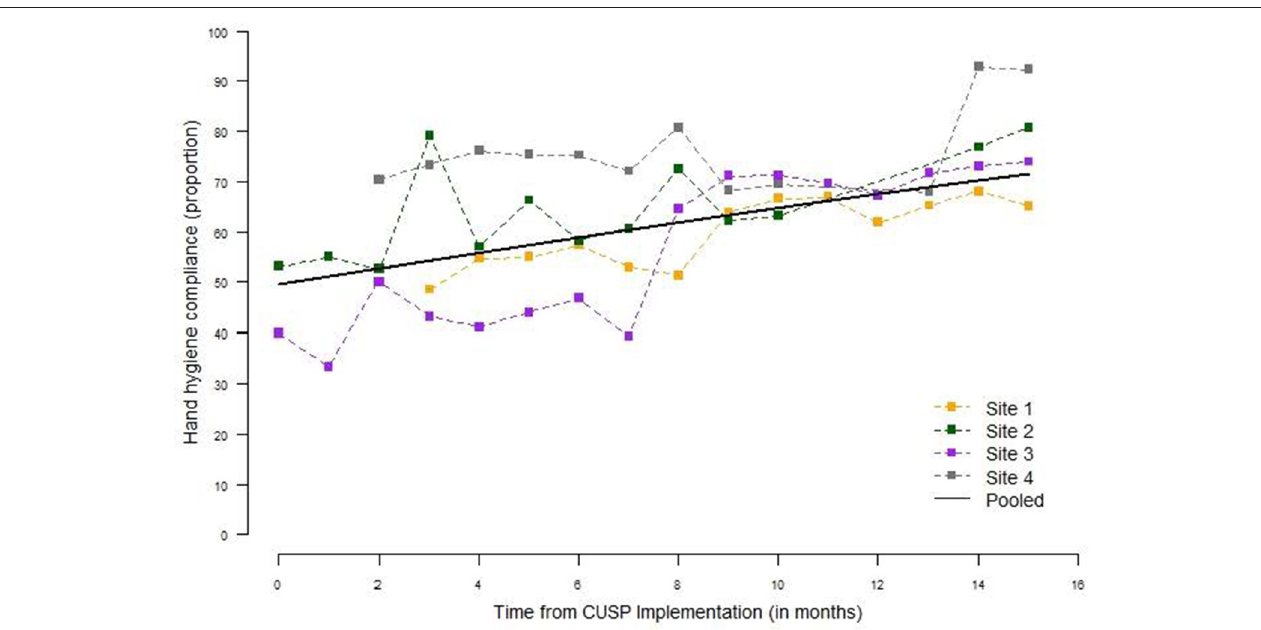
FIGURE 2 | Hand hygiene compliance by site and month, June 2018–September 2019. Monthly hand hygiene compliance was expressed as the proportion of monthly observations compliant, by site for all healthcare worker roles. Hand hygiene was monitored monthly via direct observation by trained observers. There were 8,684 opportunities for hand hygiene across all four sites over the course of the study period. The pooled hand hygiene compliance is based on a logistic regression model for observation compliance as a function of month from CUSP